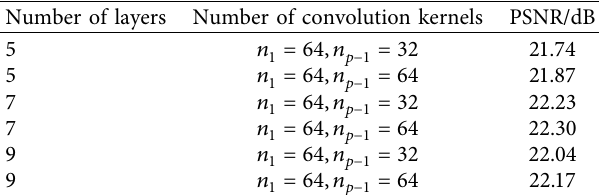
Table 2: Objective evaluation indexes of different algorithms on synthetic low-illumination images.